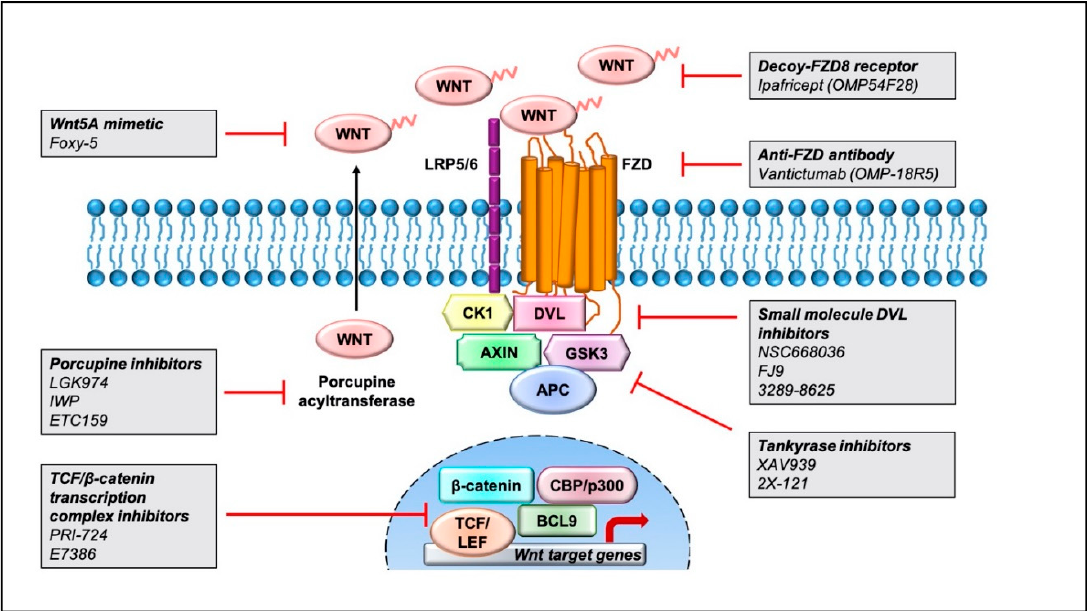
Figure 2. Pharmacological inhibitors targeting the Wnt pathway that are currently being tested for cancer treatment. Representation of pharmaceutical compounds that disrupt the Wnt pathway at several stages, including the Wnt-receptor complex, β -catenin destruction complex, and TCF / β -catenin transcriptional complex.